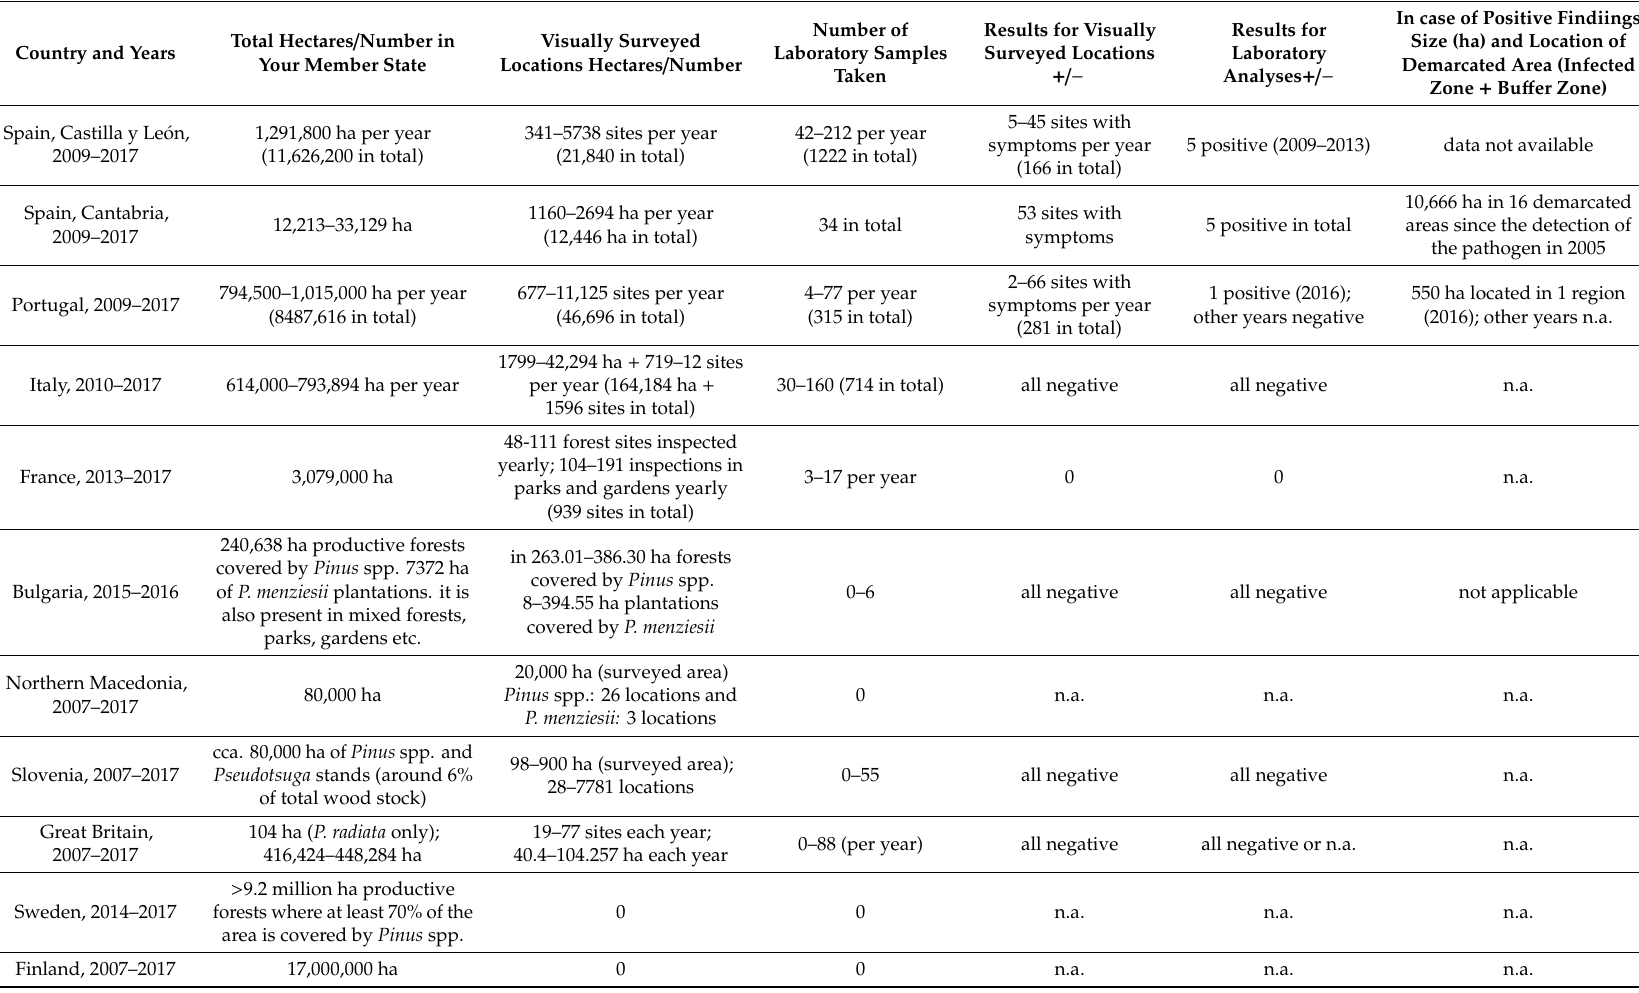
Table 3. Sampling approaches in Pinus spp. and Pseudotsuga menziesii forest (including parks, gardens etc.). The data is based on the annual reports submitted to the European Commission by the